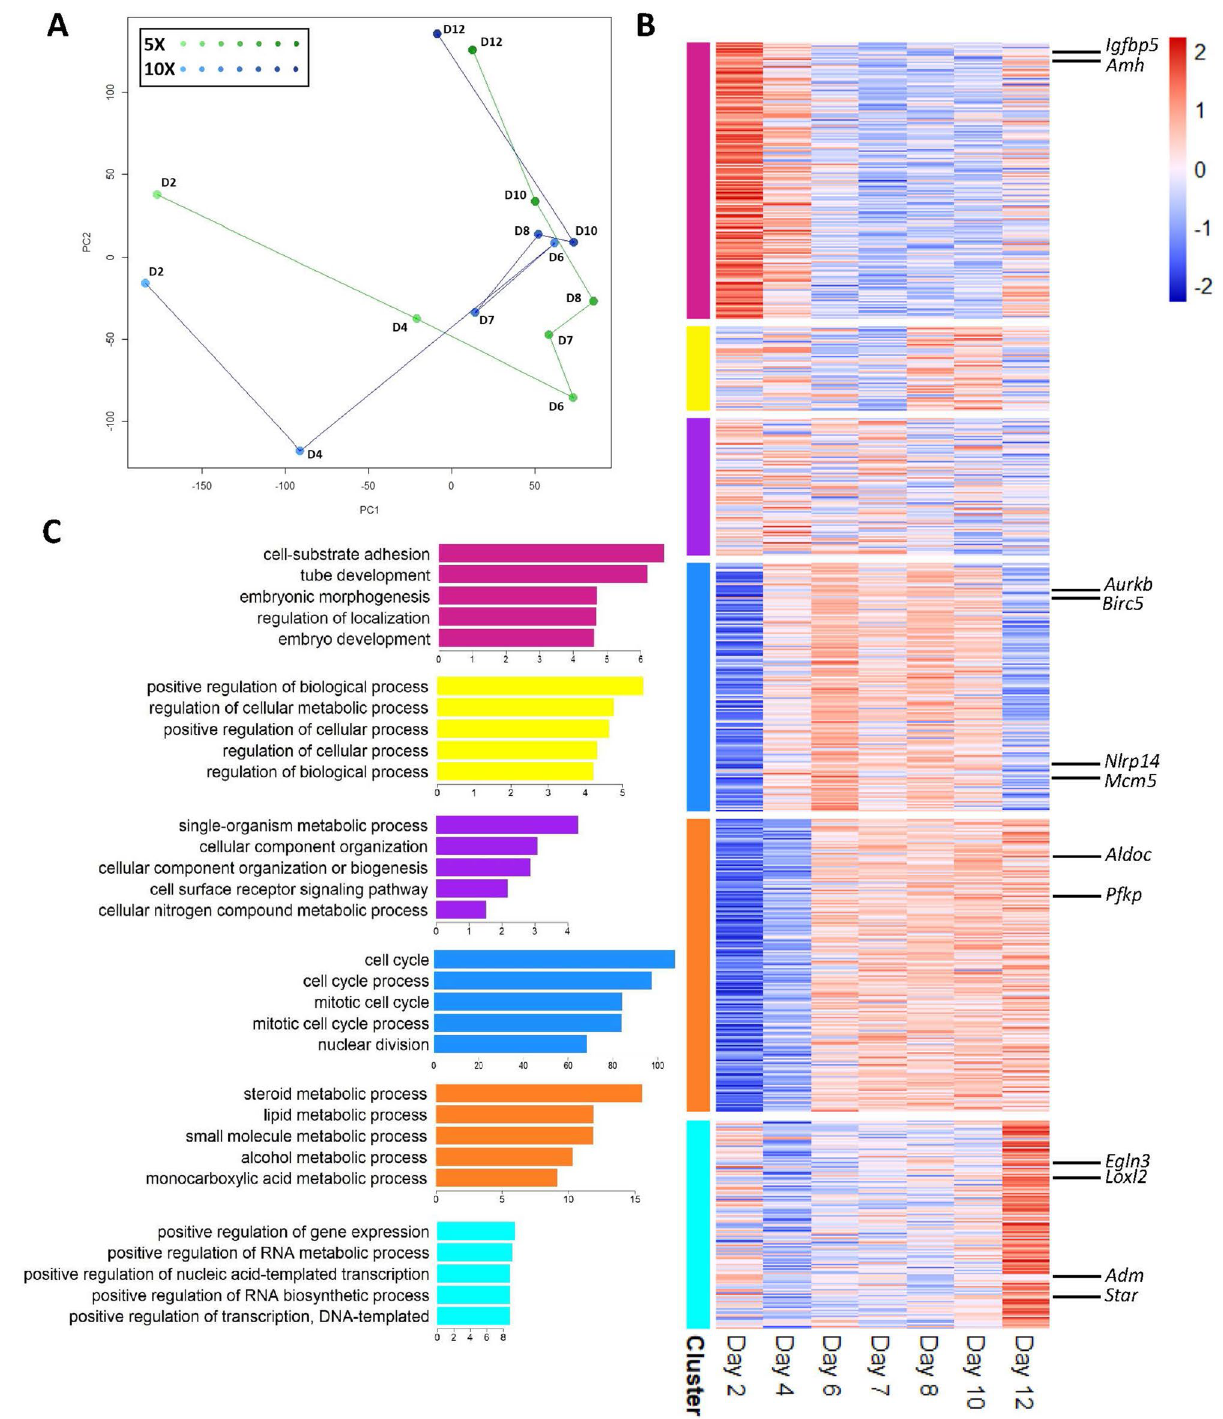
Figure 2. Somatic cells from ovarian follicles cultured in groups have dynamic temporal gene expression. ( A ) Principal component plot of the 14 microarray samples, ( B ) heatmap of standardized expression level for genes in the six clusters obtained from k-means analysis (k = 6), and ( C ) top five GO terms enriched for differentially expressed genes in each cluster from LRPath analysis (x-axis = − log( p Value)). ( B ) was generated